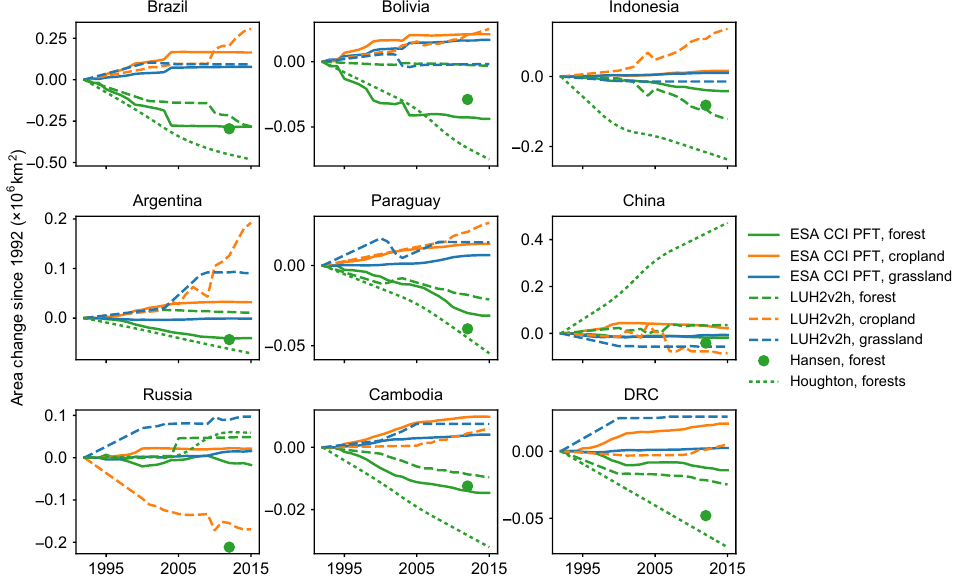
Figure 5. Net area changes in forest, cropland and grassland PFTs derived from ESA CCI land cover maps since 1992 in countries with largest net forest area loss between 1992 and 2015. Data from LUH2v2h (Hurtt et al., 2011), Hansen et al. (2013) and Houghton and Nassikas (2017) are also shown for